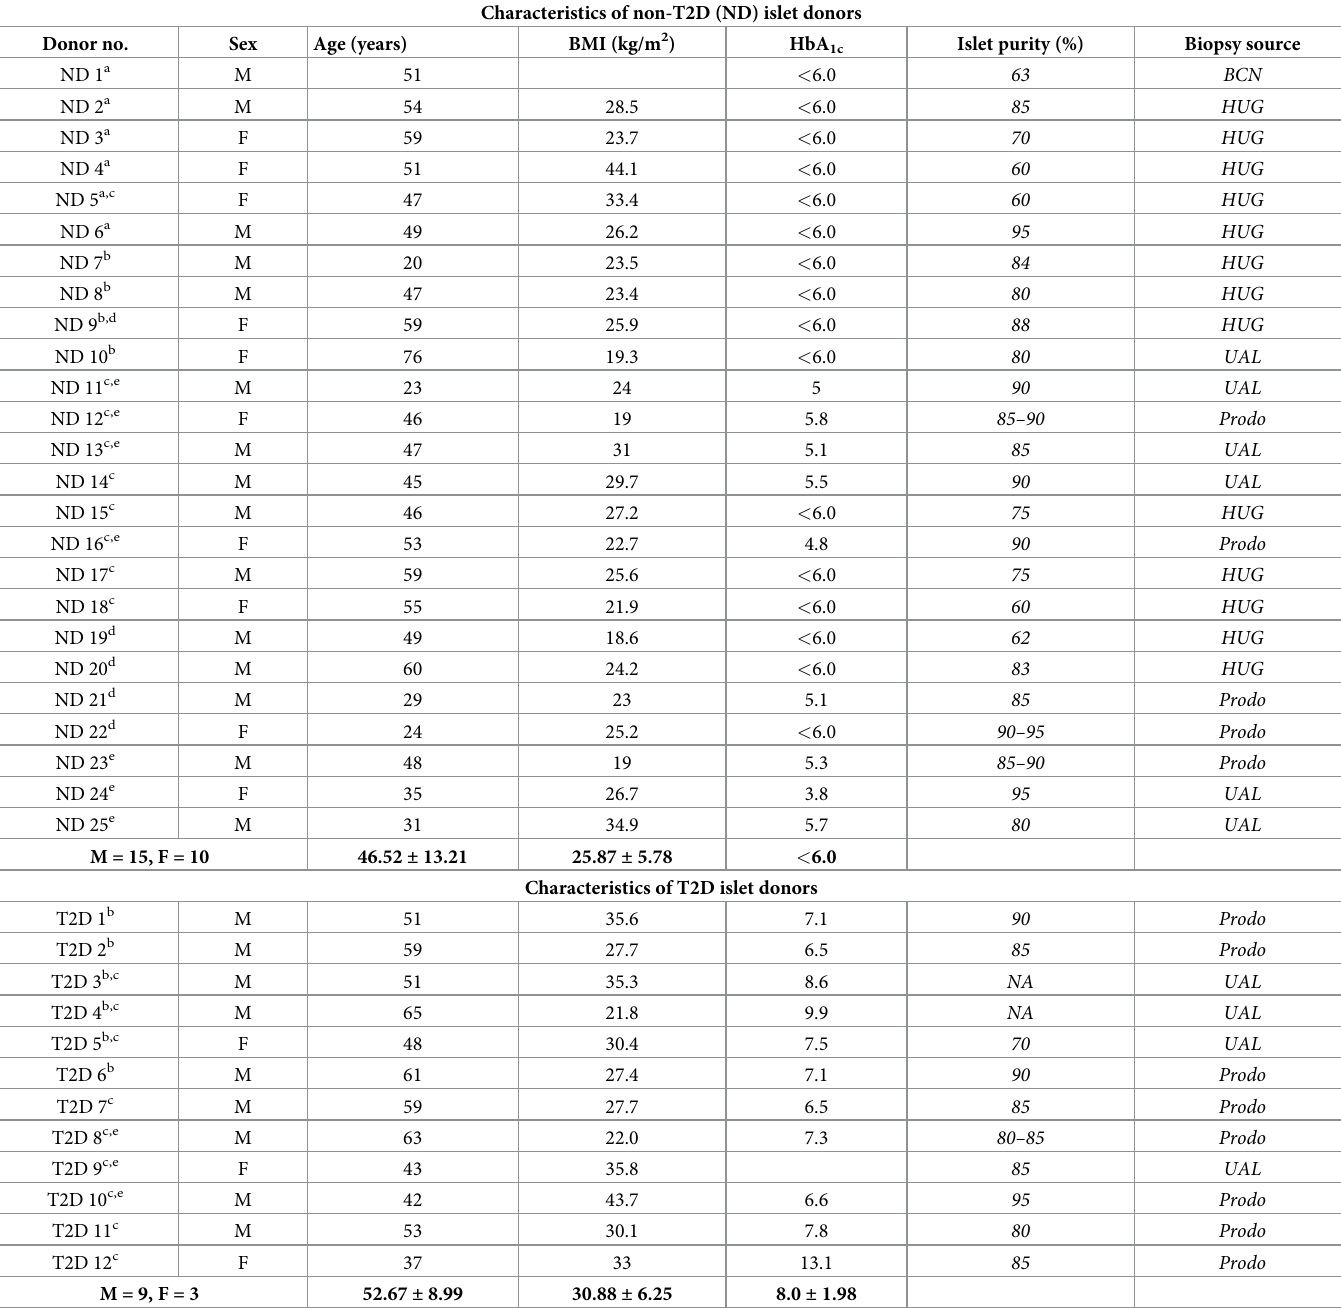
Table 1. Human donor characteristics.